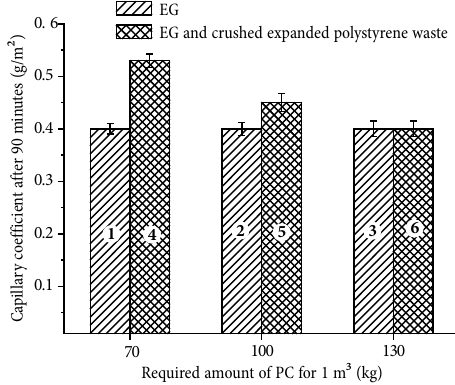
Fig. 8. Influence of the amount of PC on capillary coefficient of LWAC samples of 1÷6